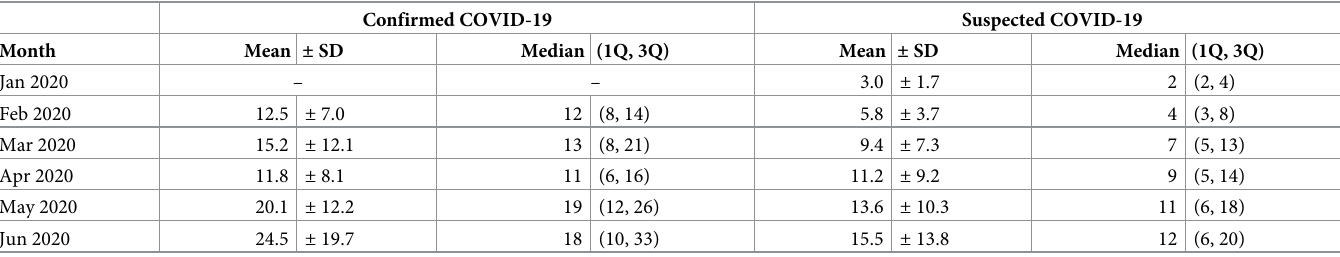
Table 2. The LOS of COVID-19 cases (day).